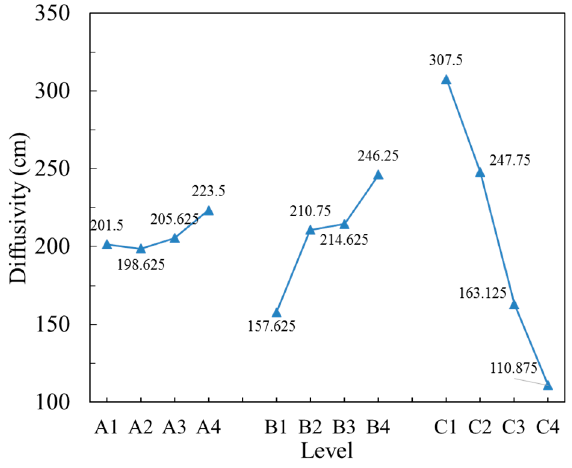
Figure 7. The average diffusivity of the slurry at each level.